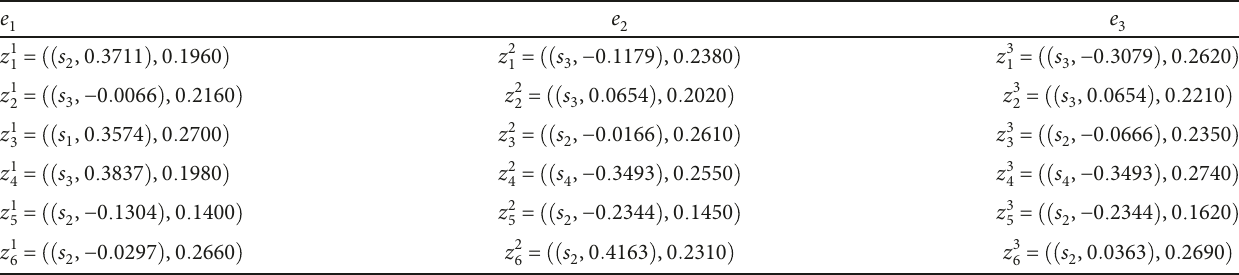
Table 7: The overall values for all